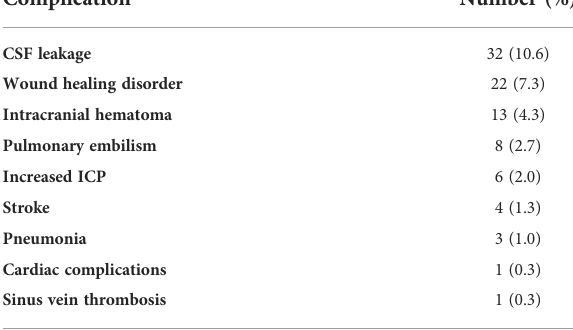
TABLE 2 Postoperative